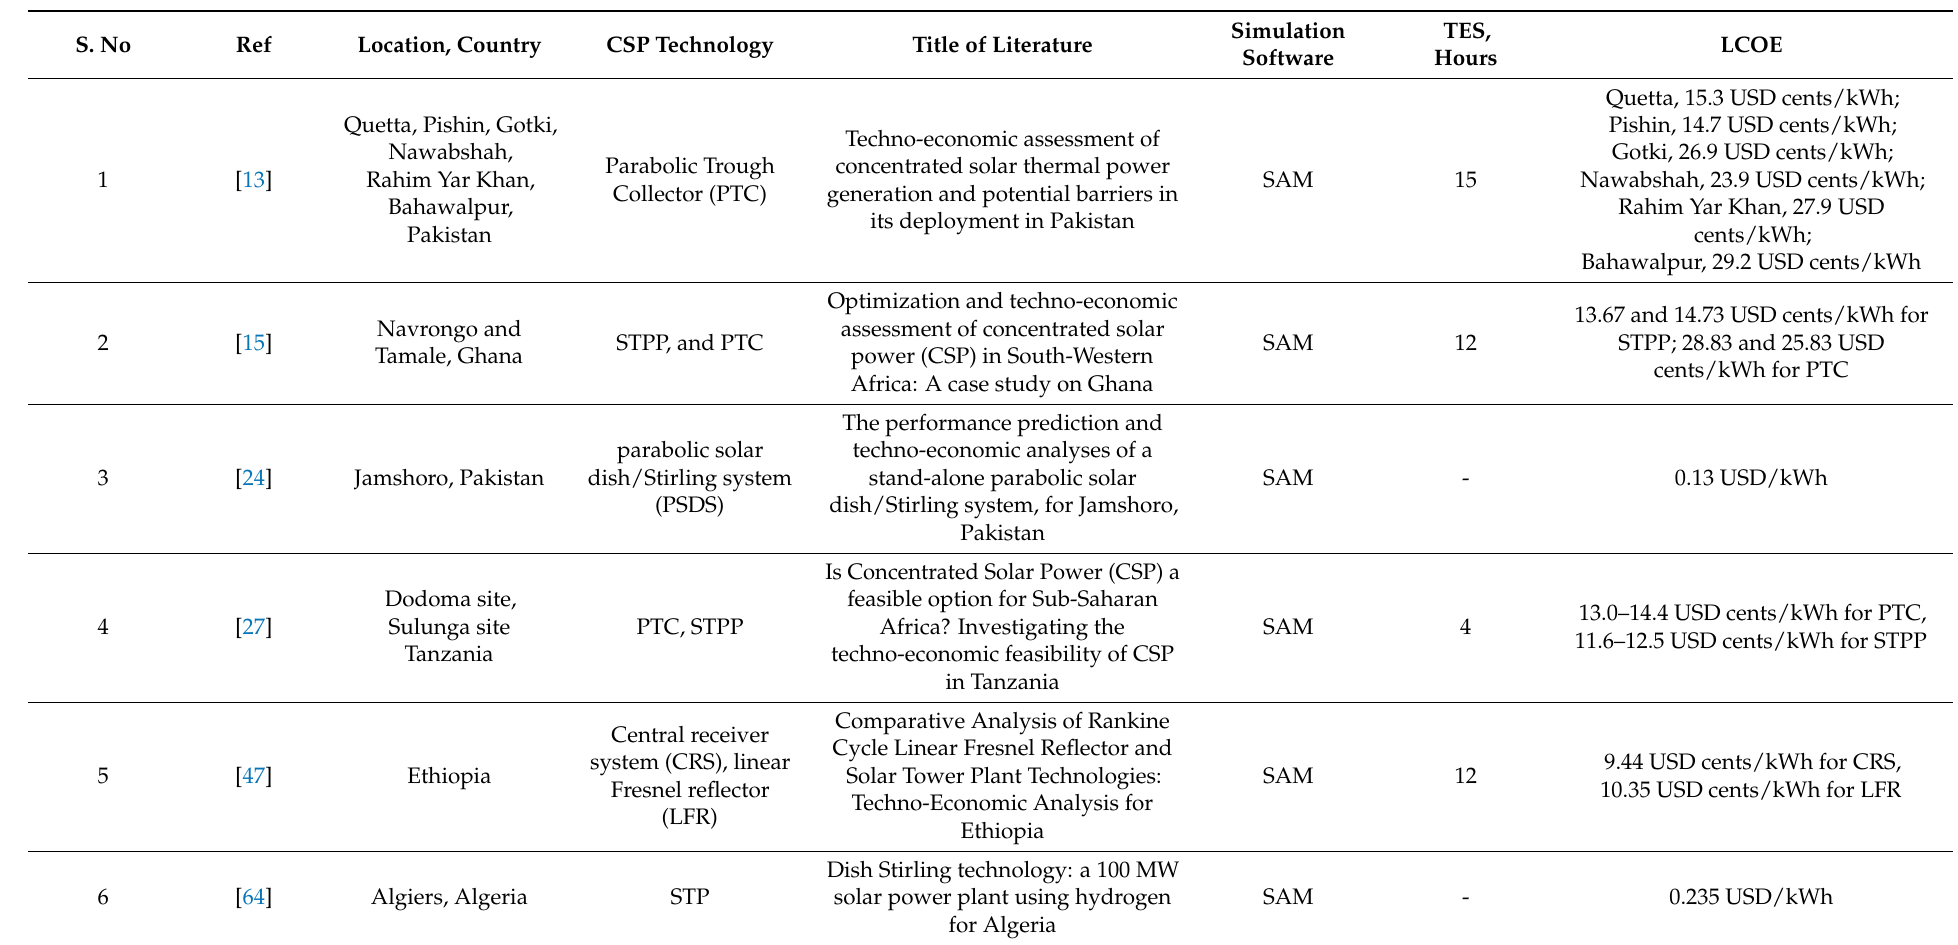
Table 5. CSP technology in other published works, for